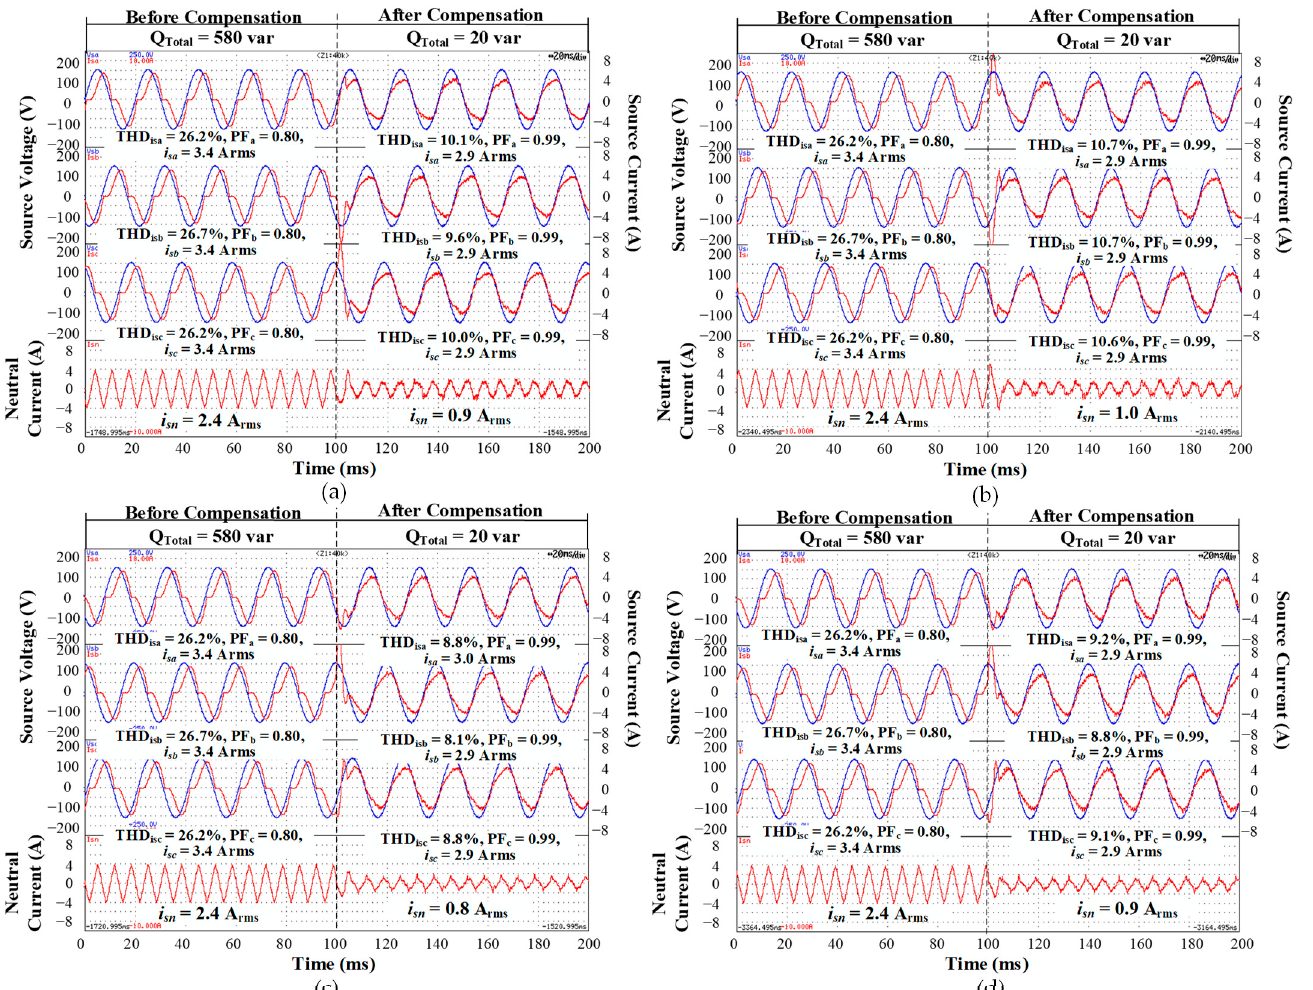
Figure 8. Experimental results of three-phase PCC voltage, source current and neutral current before and after the LC -HAPF compensation with ( a ) LQRC under 50V DC-link voltage; ( b ) LQRC under 40V DC-link voltage; ( c ) LQRIC under 50V DC-link voltage and ( d ) LQRIC under 40V DC-link voltage. (For each graph, the blue lines are the waveforms of source voltage, the red lines in the 1st, 2nd and 3rd tunes are the waveforms of source current, and the red lines in last tune are the waveforms of neutral current.)